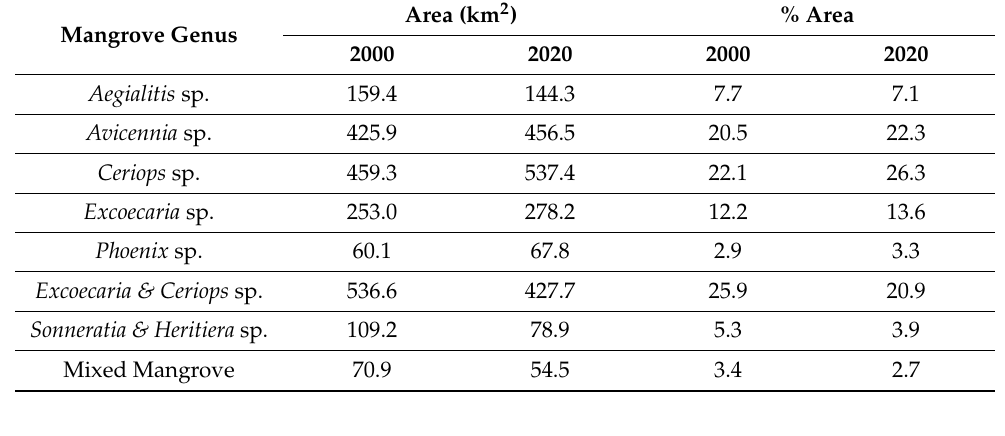
Table 3. Area (and percentage area) of principal mangrove genera in 2000 and 2020.